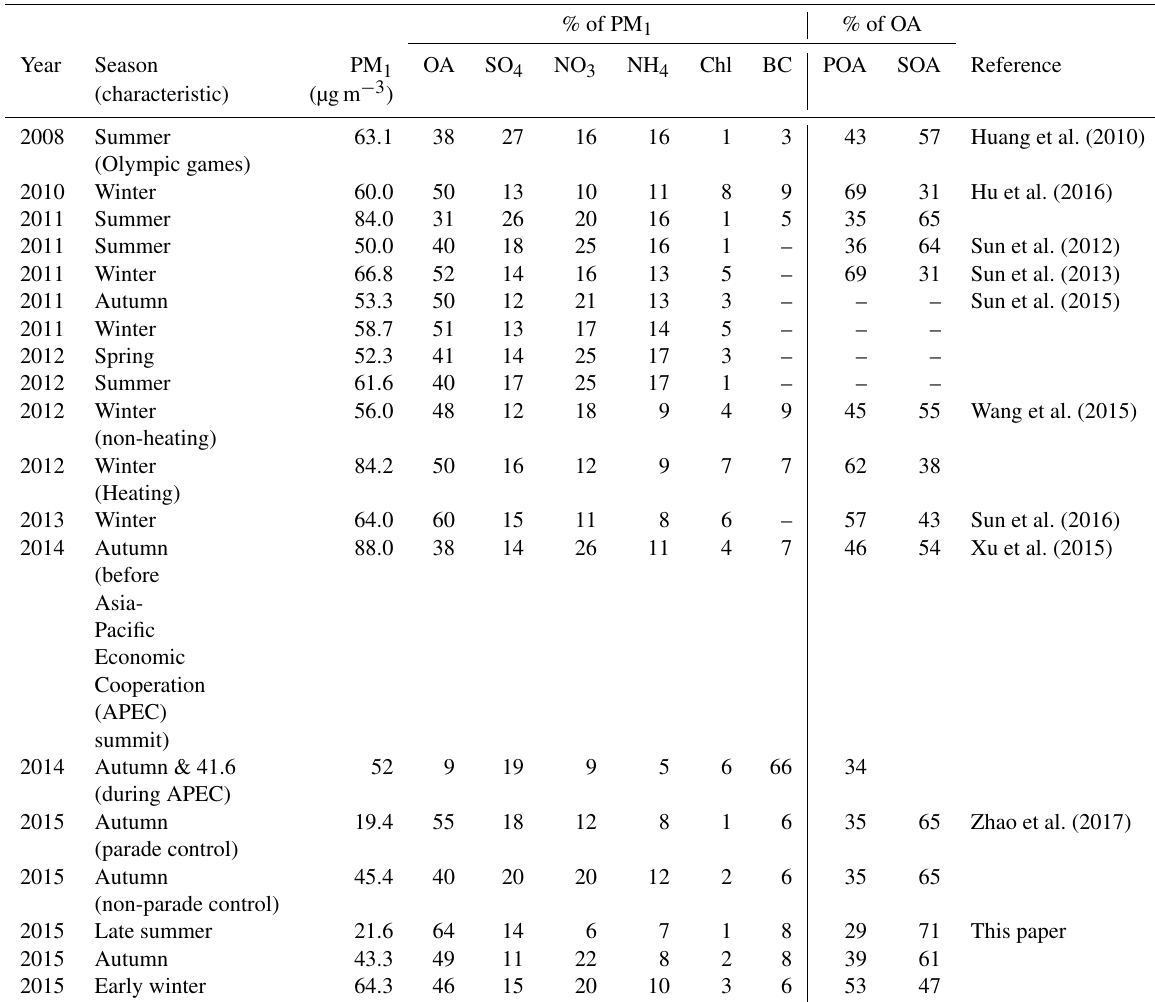
Table 1. Summary of PM 1 mass concentrations and composition as well as OA composition in Beijing during different seasons. % of PM 1 % of